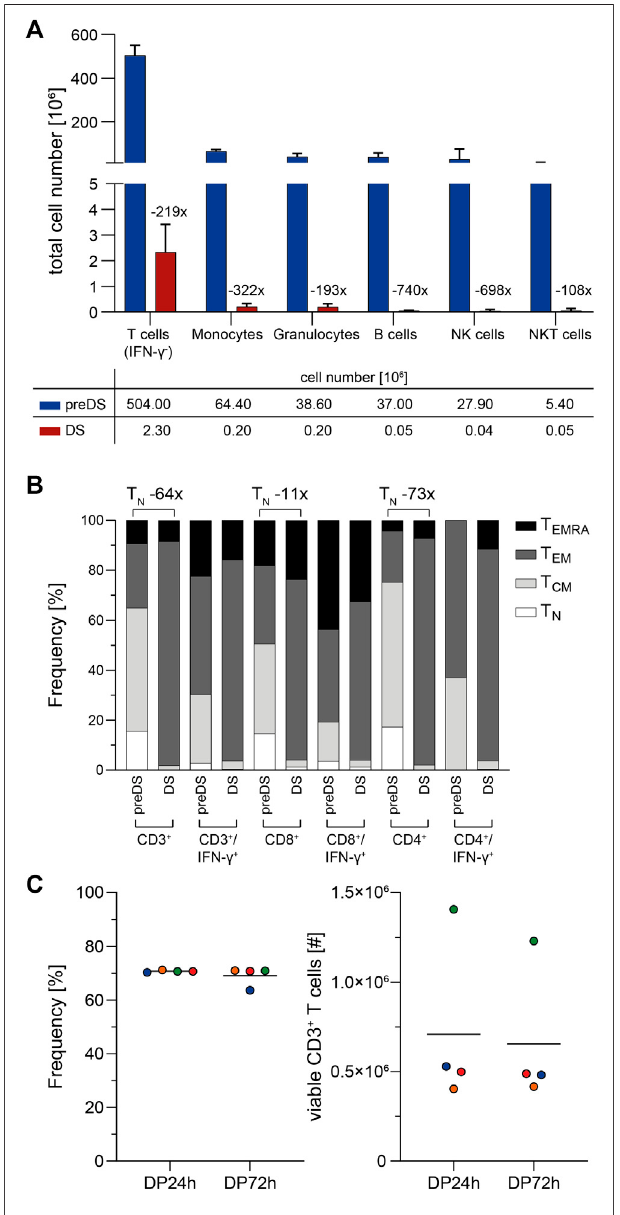
FIGURE 3 | Characterization of clinical-grade SARS-CoV-2-speci fi c T cells ( n = 4). SARS-CoV-2-speci fi c T cells were magnetically enriched under GMP-compliant conditions using Cytokine Capture System (CCS) and CliniMACS Prodigy and analyzed via fl ow cytometry. (A) Impurities of SARS-CoV-2-speci fi c T cell product. Shown is the fold-reduction of indicated immune cell subsets in the T cell product (drug substance, DS) compared to preDS (pre-enrichment). Bars and lines represent mean and SD, n = 4 manufacturing runs. IFN- γ : Interferon-gamma; NK cells: Natural Killer cells, NKT cells: Natural Killer T cells. (B) Memory phenotype composition of T cell product (DS) compared to preDS. Numbers above bars indicate fold change of naïve T cells (T N ) between DS and preDS within indicated T cell subsets. T